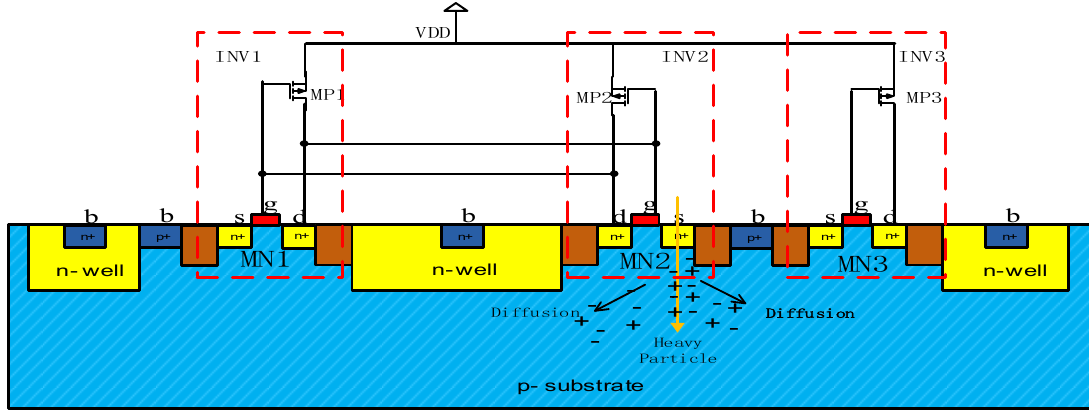
Figure 8. A particle strikes the drain central region of MN2 transistor perpendicularly. Cross-sections of layout in a cell of SRAM.